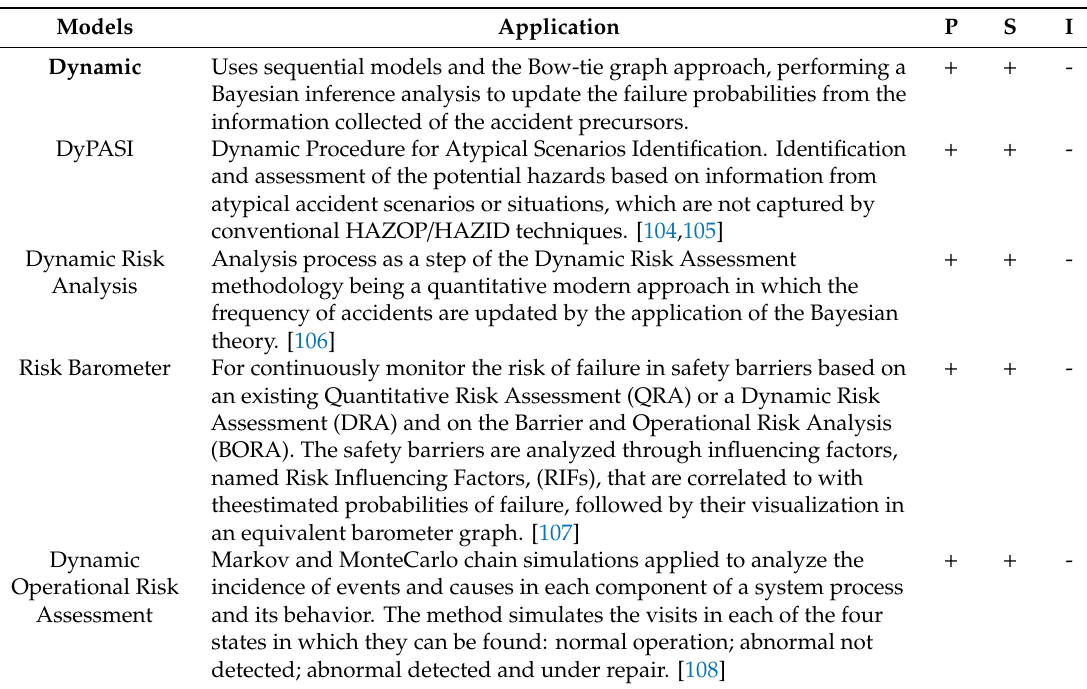
Table 4. Existing dynamic models.